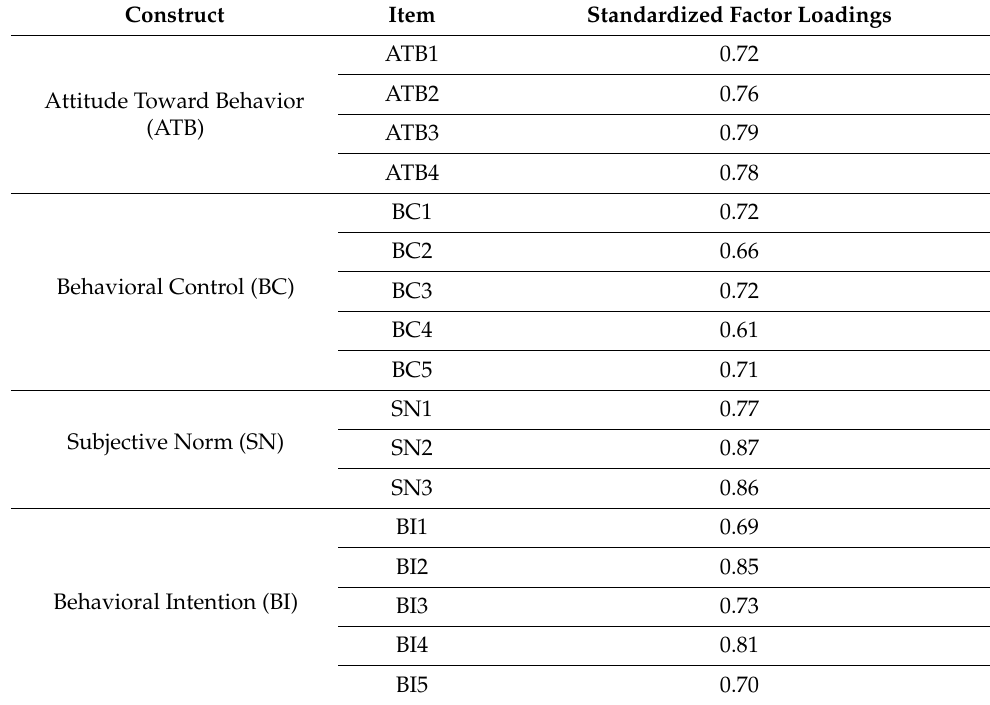
Table 5. Convergent validity of standardized factorial loadings.